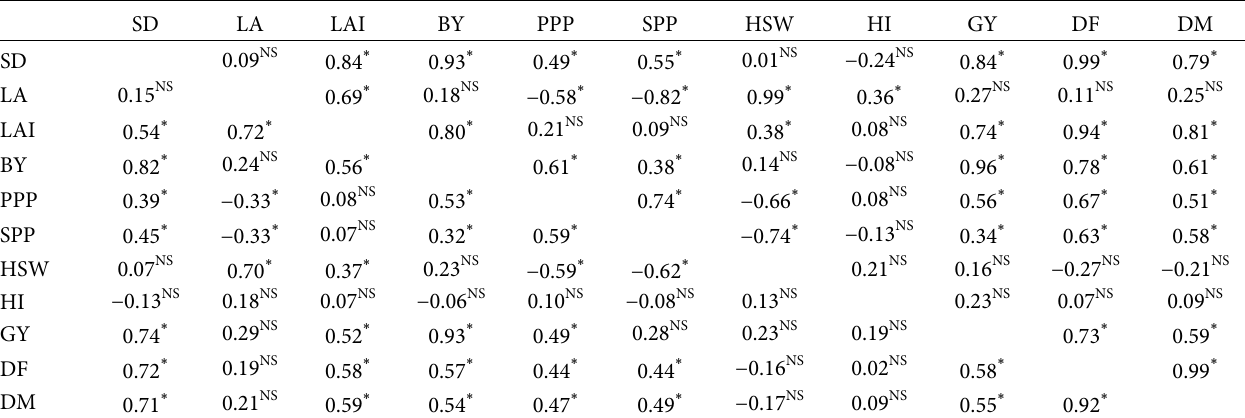
Table 4: Genotypic (above diagonal) and phenotypic (below diagonal) correlation coefficients for agronomic traits of common bean